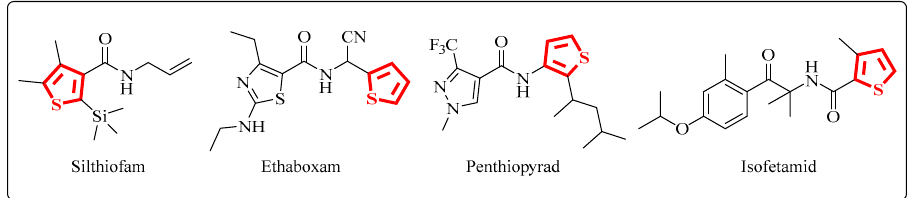
Figure 2. The structures of thiophene-containing agricultural fungicides.